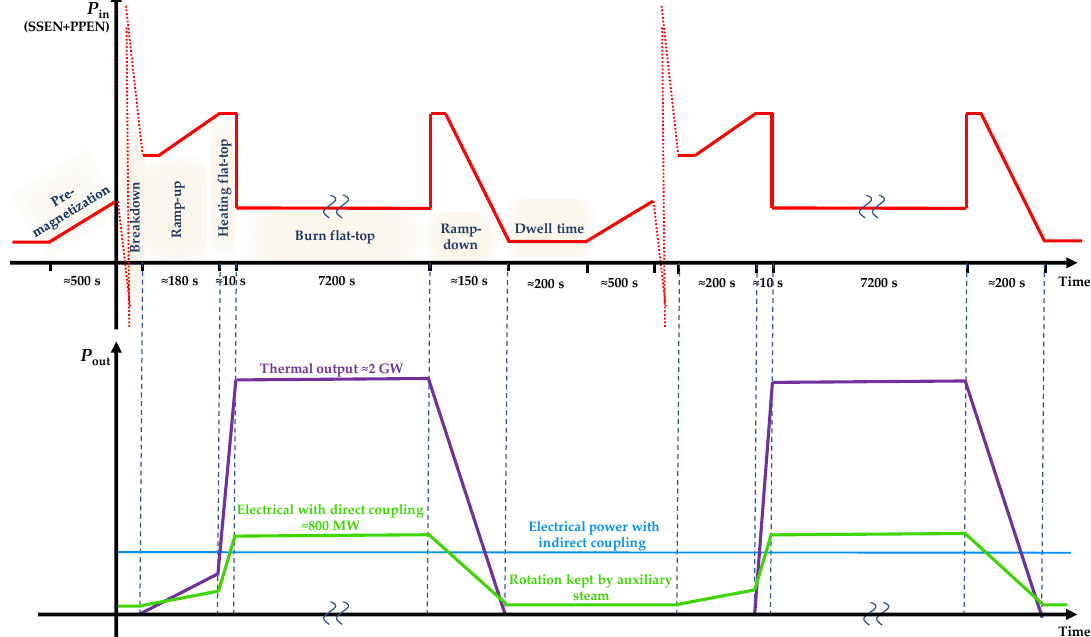
Figure 5. Qualitative (not in scale) curves of input (red line) and output powers. The thermal power produced by the plasma and fusion processes (purple line) can be transformed in an electrical power whose characteristics are di ff erent for the direct (green line) and indirect coupling (blue